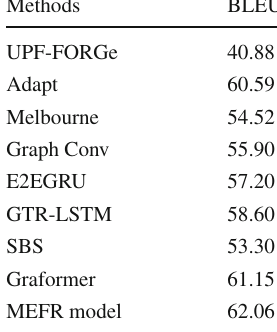
Table 4 Results of different generation models on WebNLG test set with seen